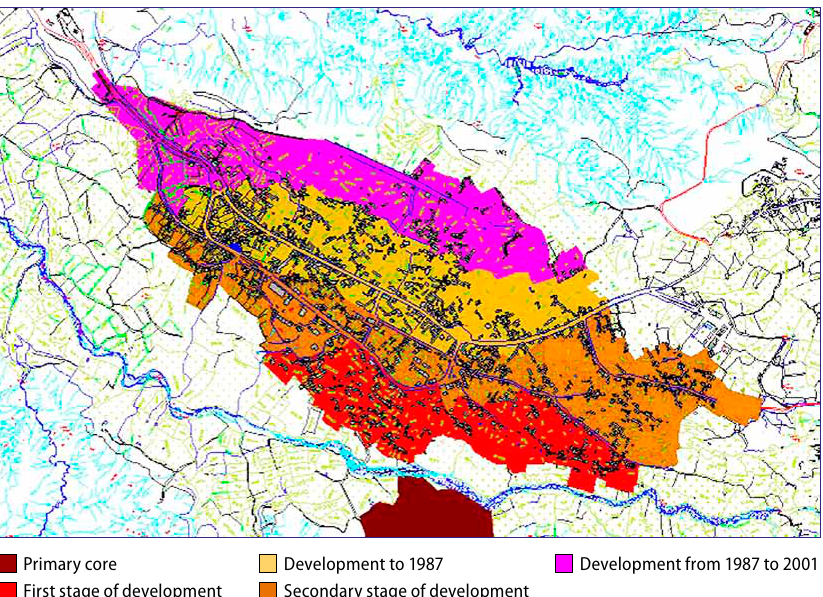
Primary core Development from 1987 to 2001 developmentDevelopment to 1987 Secondary stage of First stage of fig. 1. The staged development of Zonuz city (created by author)